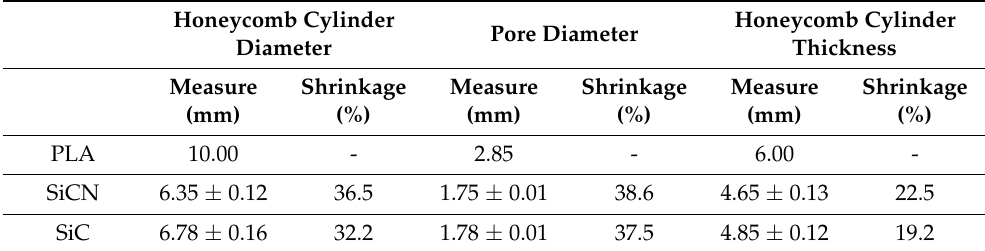
Table 1. Dimensions of 3D PLA, SiCN and SiC ceramics as well as the shrinkage after